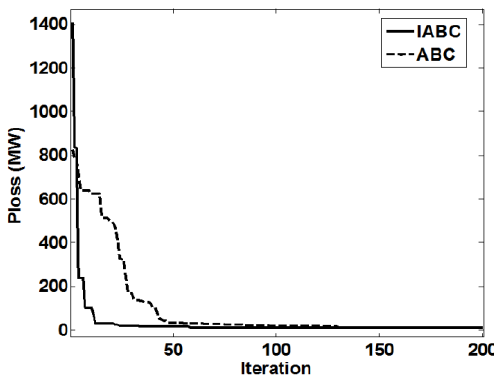
Figure 14. Convergence characteristics of power loss of the IABC and ABC algorithms for the IEEE 57-bus system.